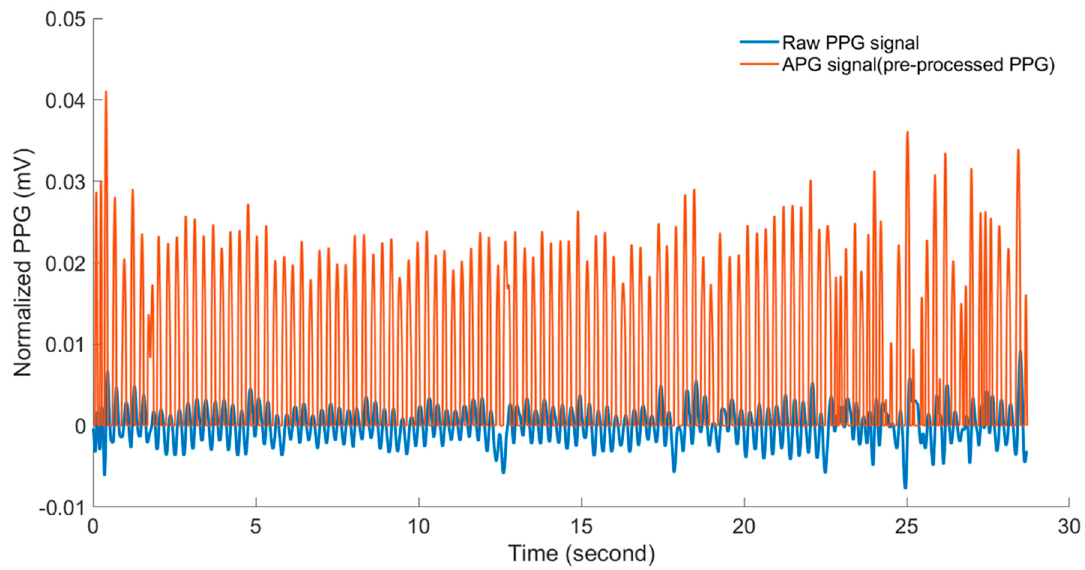
Figure 4. The acceleration plethysmogram (APG) signal (red line) resulting from pre-processing compared to the raw PPG signal (blue line), obtained from an incubated fertile egg at embryonic day ED09.